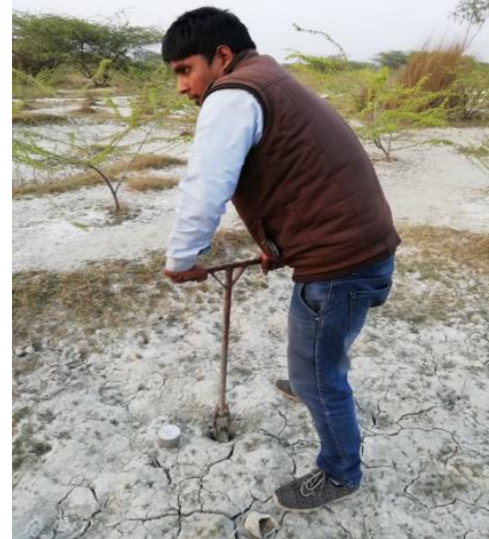
Figure 4: Soil sample collection for sodic soil